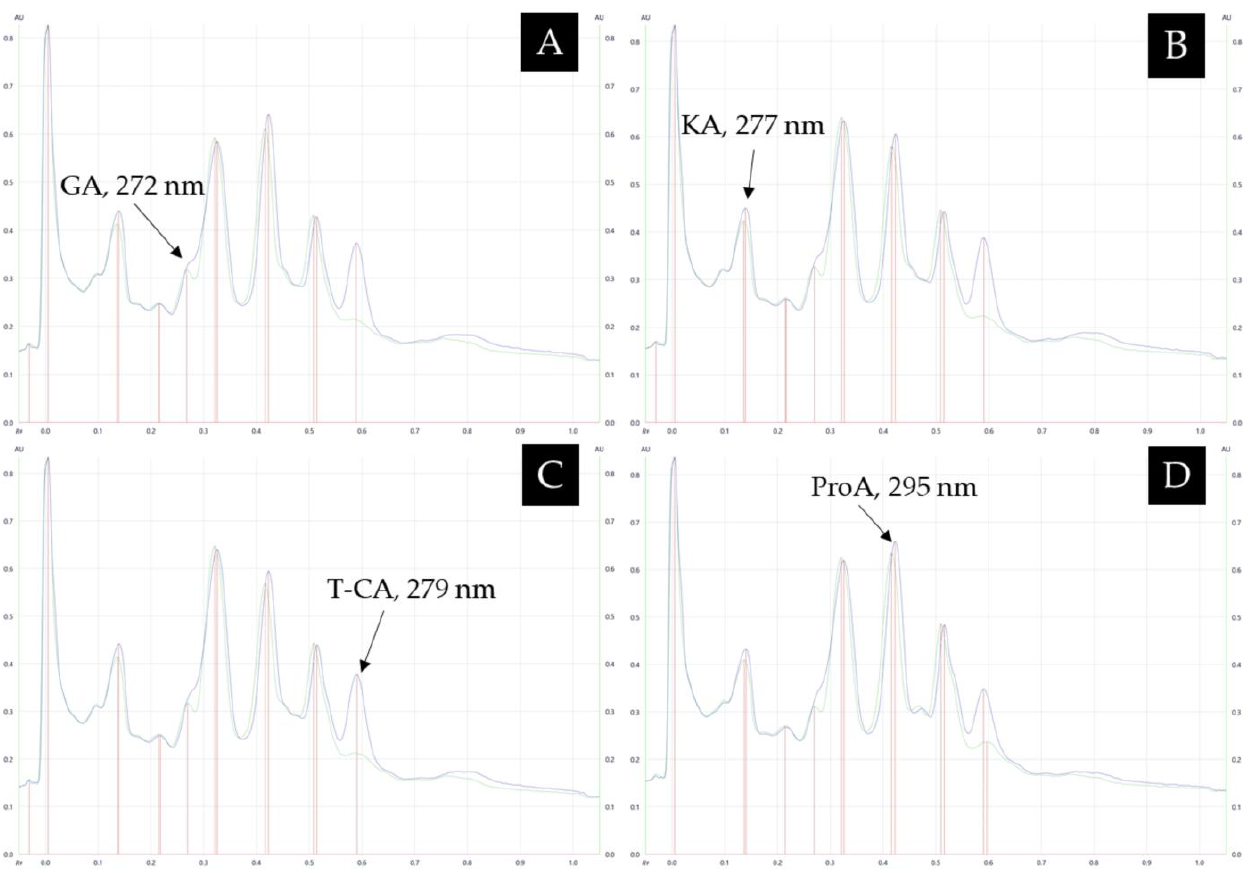
Figure 7. ( A – D ) Peak profile comparison of Calothamnus spp. (Red Bell) honey (green) and Calothamnus spp. (Red Bell) honey spiked with the identified compounds based on Database 2A and 2B (blue) scanned at the λmax of each specific compound prior to derivatisation.